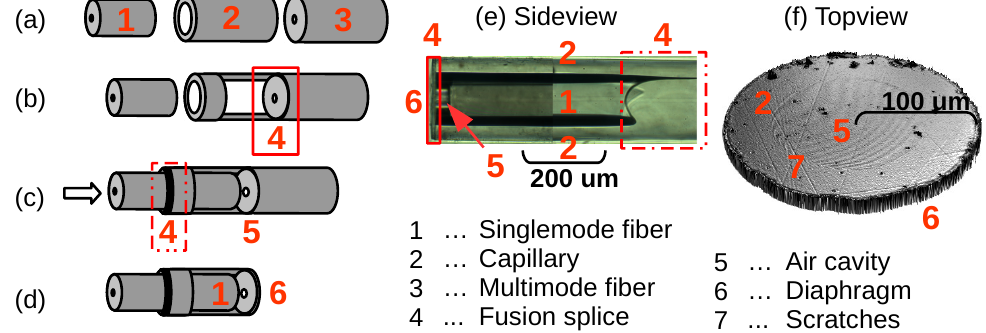
Figure 5. The optical fibre pressure and temperature sensor assembly steps: ( a ) SMF, glass capillary (CAP) and multi-mode fibre (MMF); ( b ) the CAP is spliced to the MMF; ( c ) and the SMF is pushed into the CAP and fused together; ( d ) the MMF is polished to become the diaphragm; ( e ) 400 × side view magnification of the OFPTS; ( f ) top view of the diaphragm, captured by a Vecco interferometer.